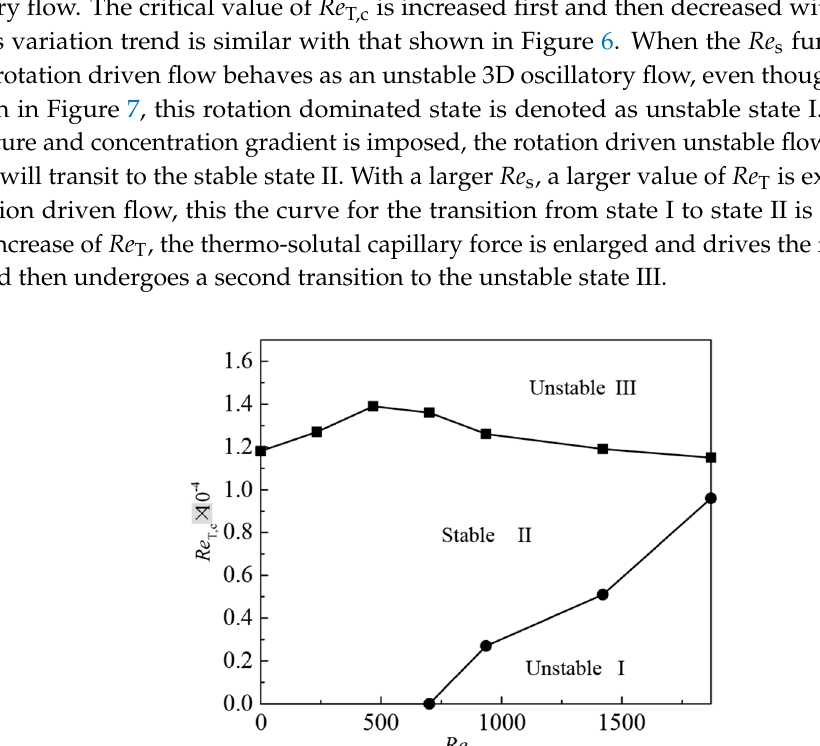
Figure 7. Stability diagram for the co-rotation of crystal and crucible when Re c = 234.